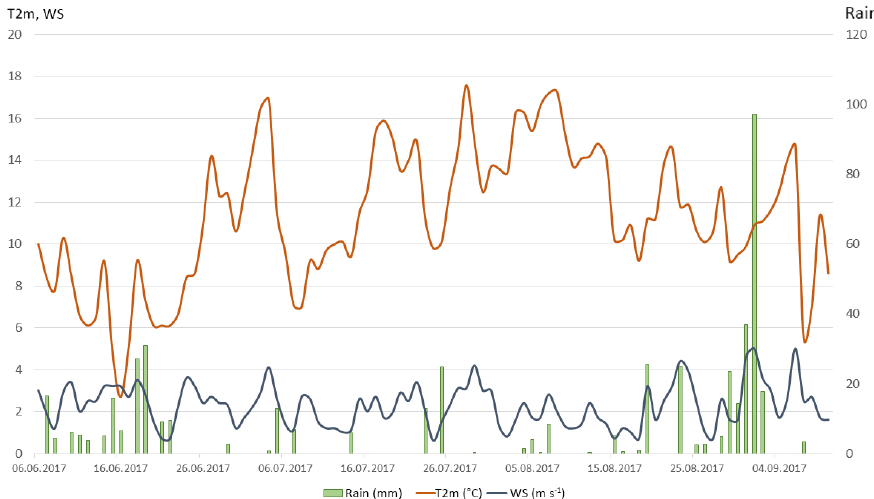
Figure 11. An example of temporal variability of average daily temperature, wind speed, and precipitation sum at the base camp (point AWS – “base camp”): Rain – precipitation, mmd − 1 ; T2m – air temperature, ◦ C; WS – wind speed, ms − 1